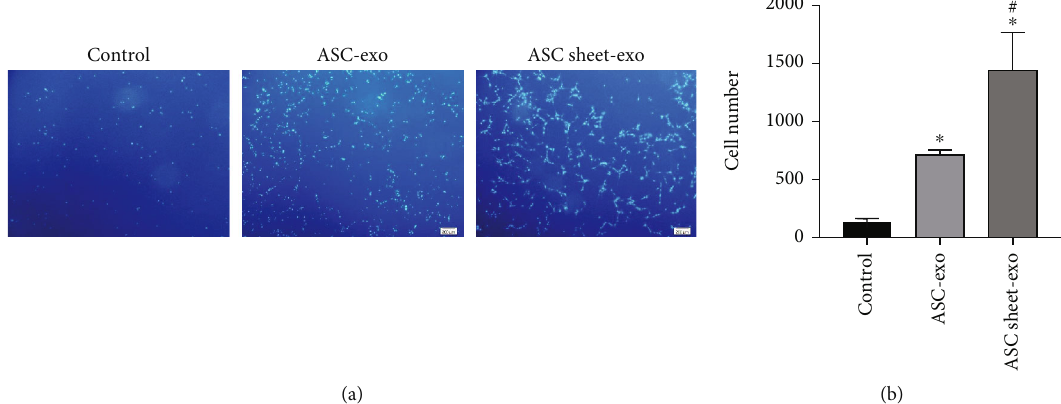
Figure 13: E ff ects of ASC-exo and ASC sheet-exo on the migration of ECs in the transwell assay. (a) Representative images of ECs that had migrated through the membrane at 48h. Scale bars: 100 μ m. (b) The number of migrated ECs at 48h. ∗ p < 0 : 05 , versus the control group; # p < 0 : 05 , versus the ASC-exo